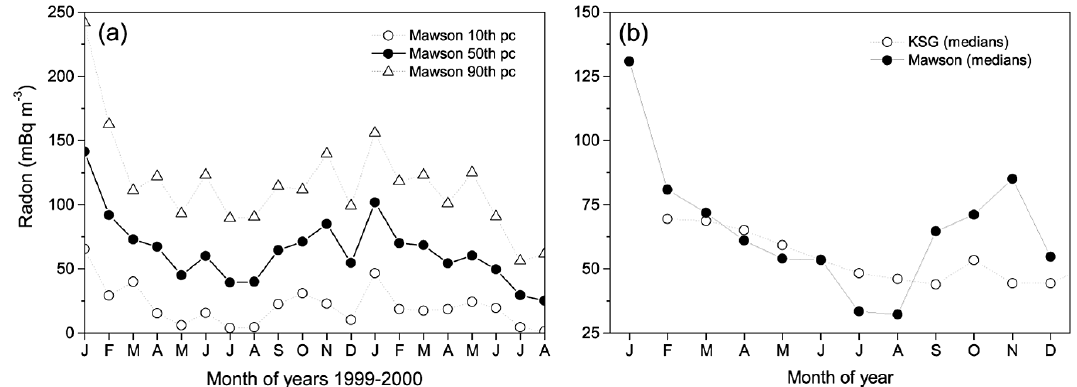
Figure 8. (a) Monthly distributions of adjusted hourly Mawson radon concentrations, and (b) comparison of median monthly radon concen- trations between KSG and the adjusted Mawson data set (1999–2000 composite